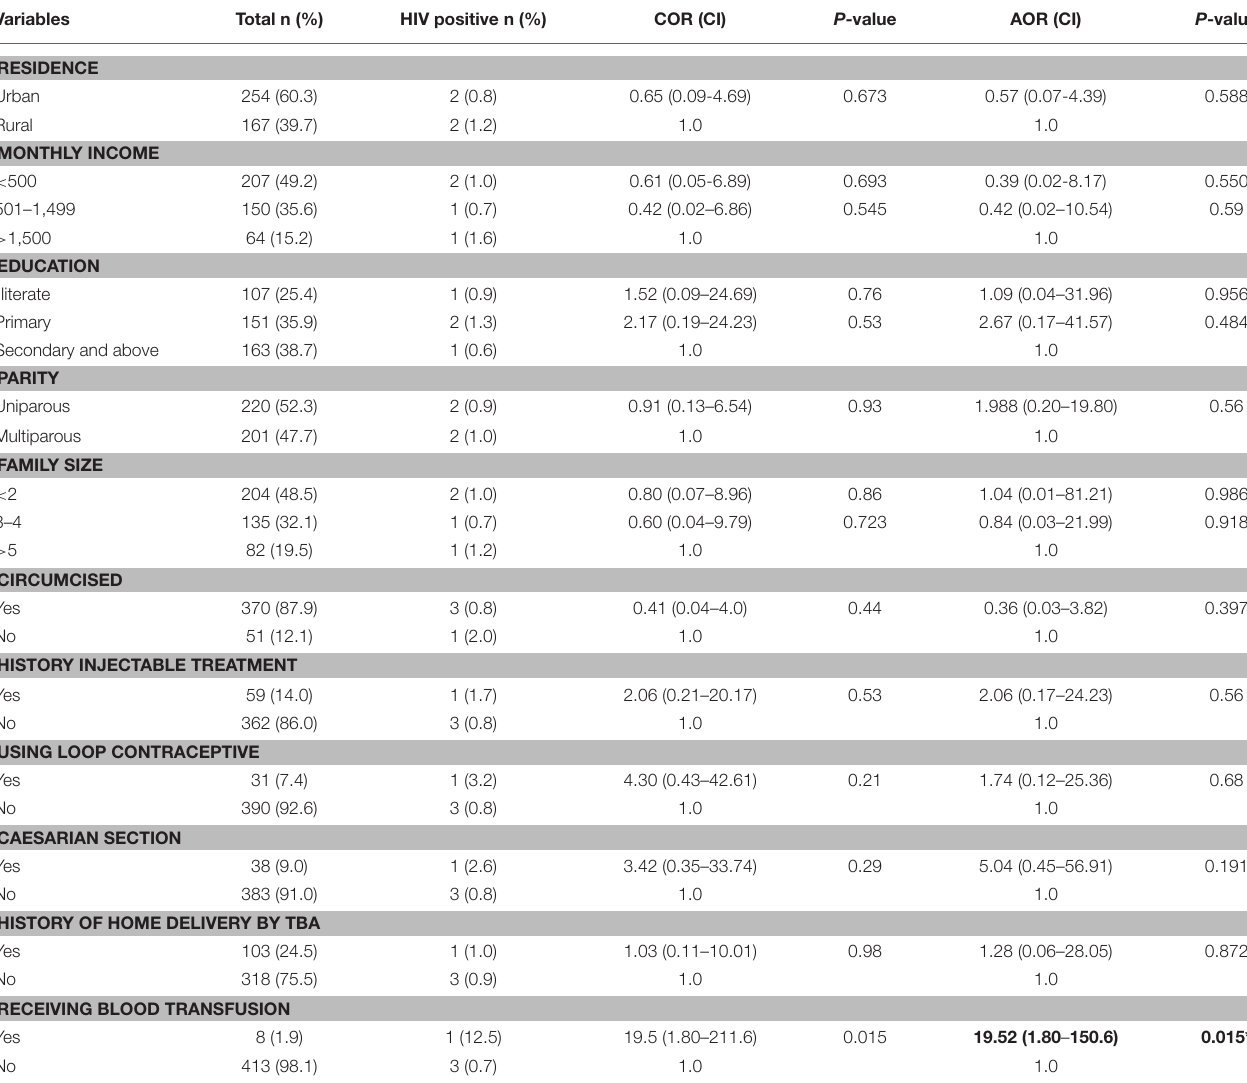
TABLE 3 | Factor associated with HIV positivity among pregnant women attending antenatal care at East Wollega Administrative Zones, Ethiopian, 2014 ( n = 421).